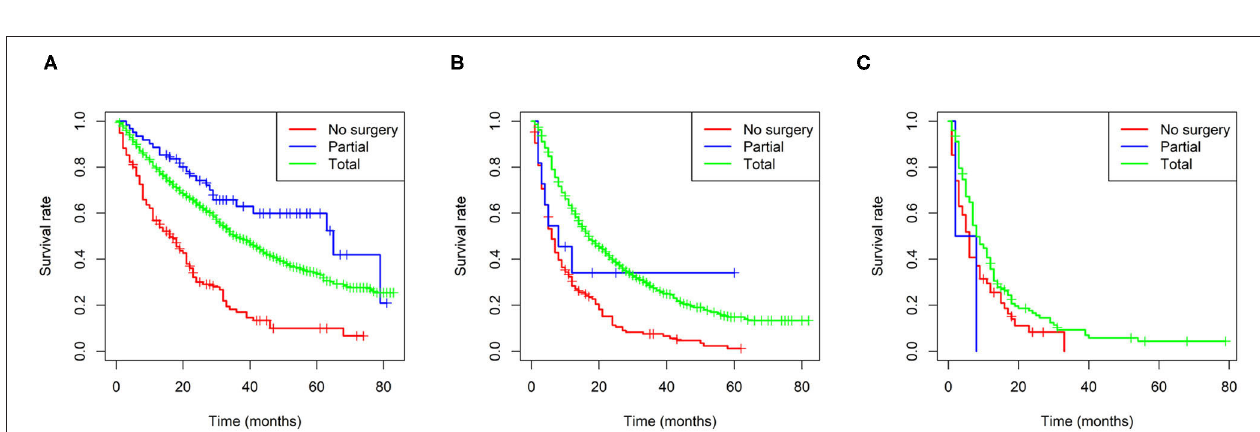
FIGURE 4 | Kaplan-Meier curves of the low-, intermediate- and high-risk groups in all cohorts (A) , the training cohort (B) , and validation I + II cohort (C) .